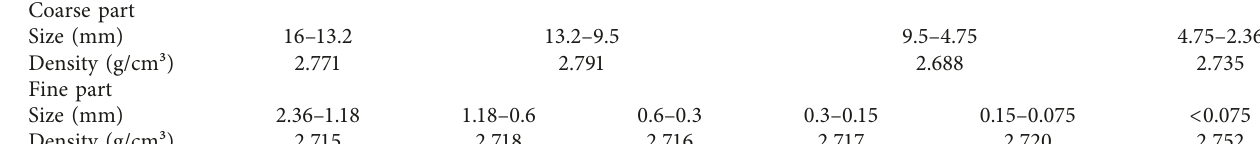
Table 3: Base properties of aggregates.